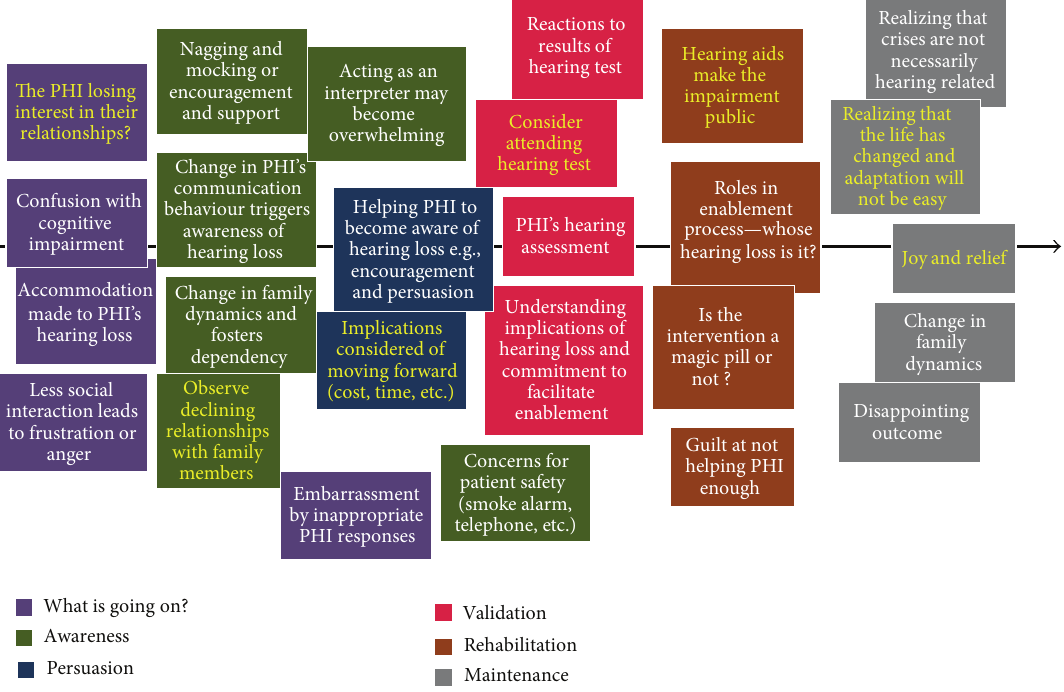
Figure 3: Professionals’ perspective of the communication partners’ journey (stages identified only by professionals are highlighted in yellow text) [8].